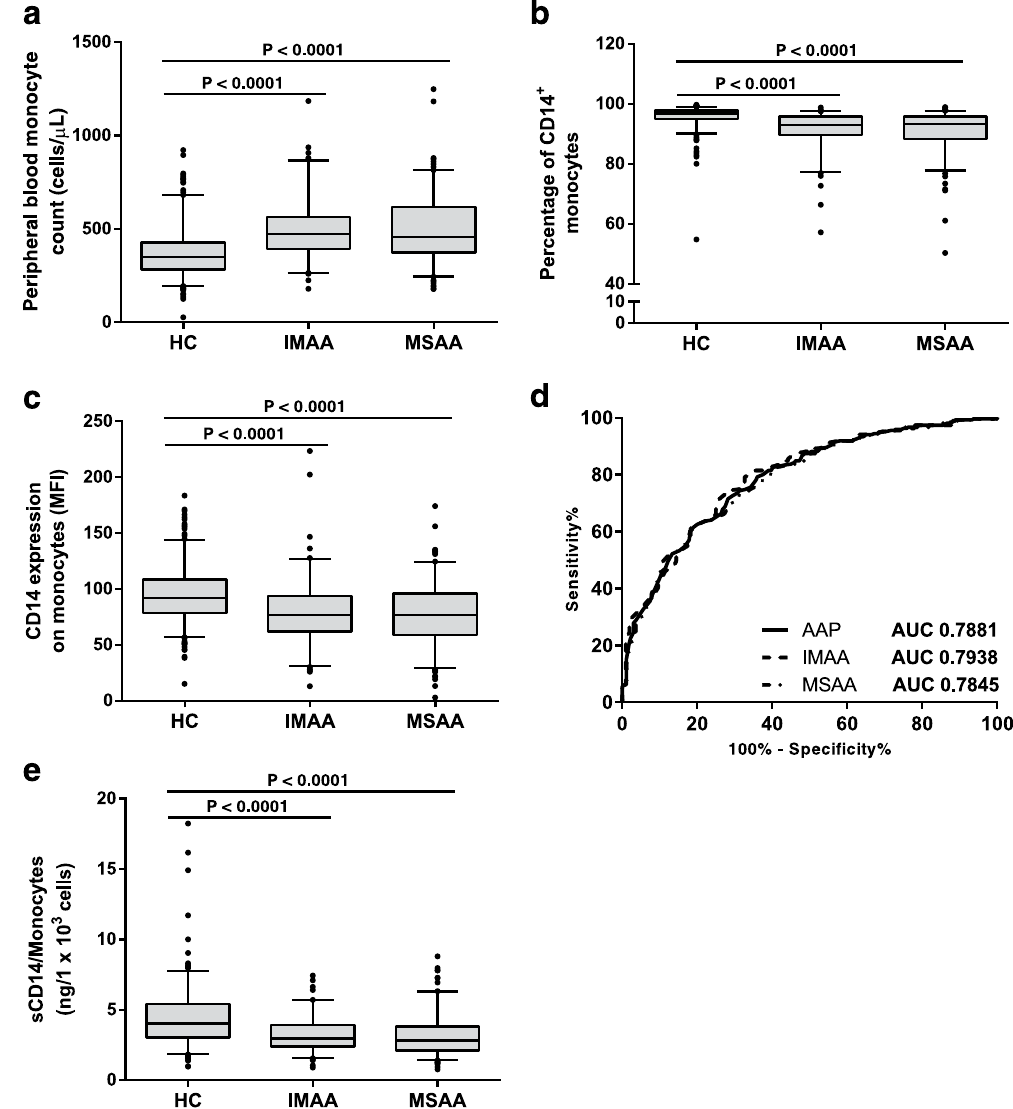
Figure 2. Monocyte count and mCD14/sCD14 levels in AA and HC. ( a ) Peripheral blood monocyte count in IMAA, MSAA and HC. Percentage of CD14 + cells ( b ) and mean fluorescence intensity (MFI) of CD14 on monocytes ( c ) in IMAA, MSAA and HC. ( d ) ROC curve for the percentage of CD14 + monocytes. ( e ) Relative sCD14 levels (ng/1 × 10 3 monocytes) in serum samples from IMAA, MSAA and HC. Numbers on the graphs represent P -values (Mann-Whitney U test).